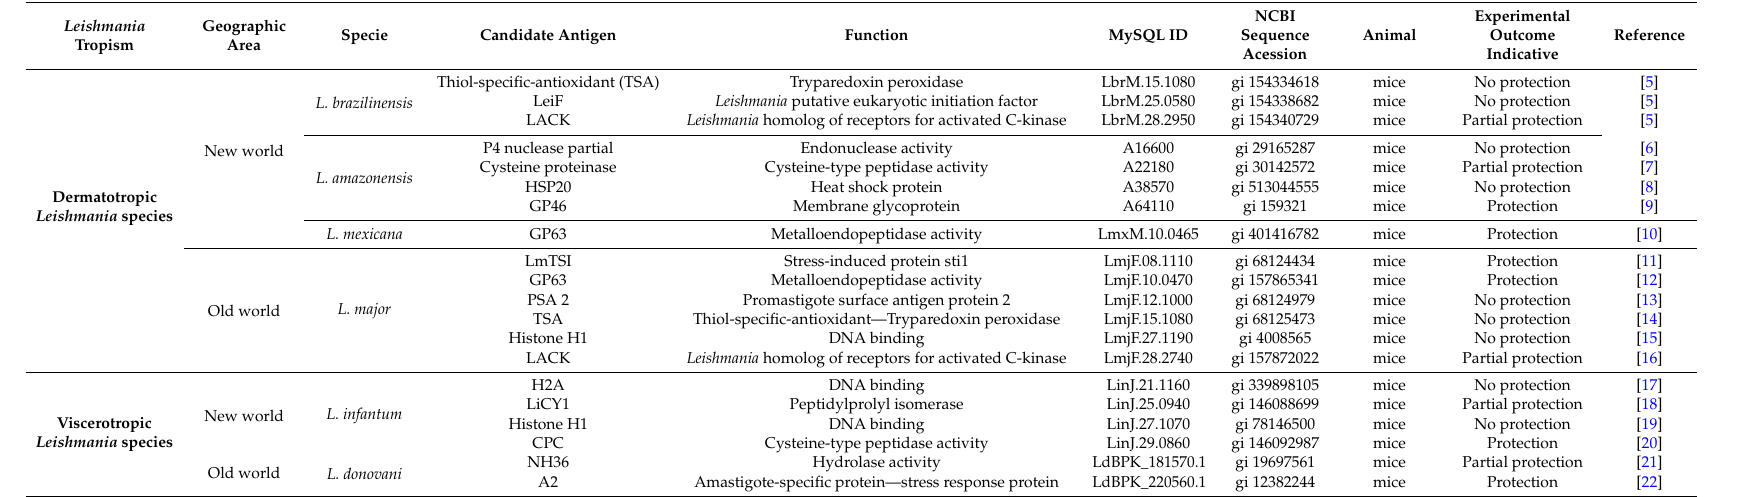
Table 1. Selected candidate antigens from dermatotropic and visceratropic Leishmania species to leishmaniasis vaccine development. Proteins in literature tested in mice model were selected